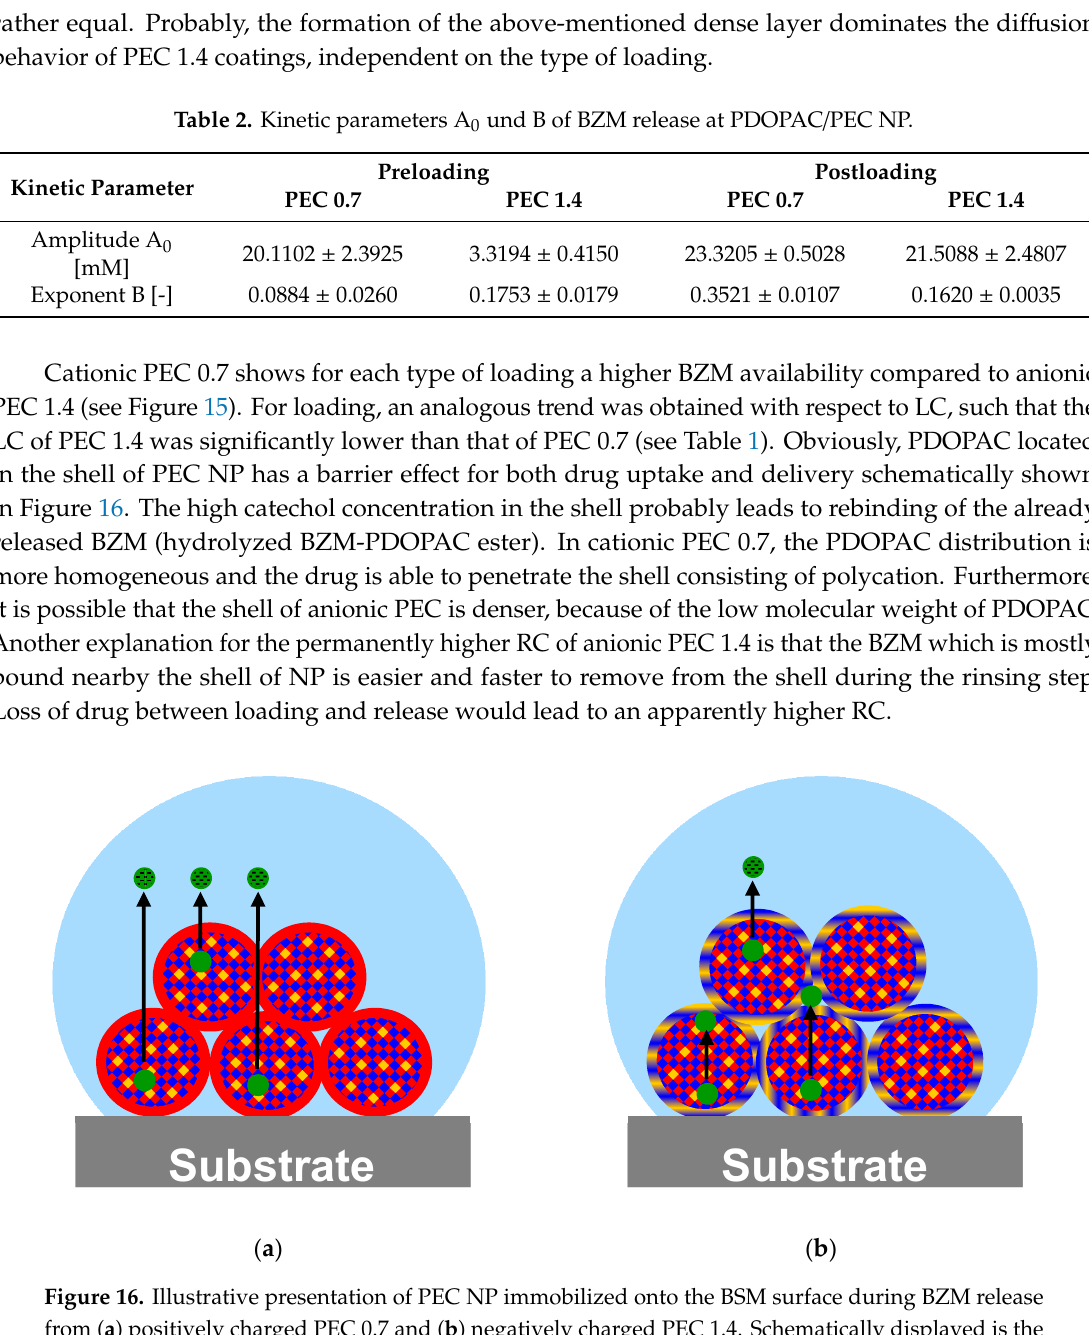
Table 2. Kinetic parameters A 0 und B of BZM release at PDOPAC/PEC NP.